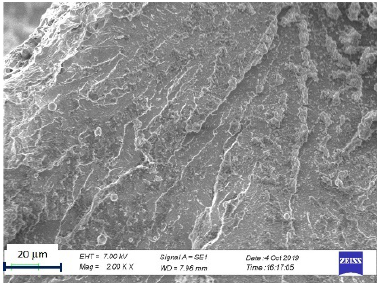
Figure 11: Fatigue fracture surface of on land